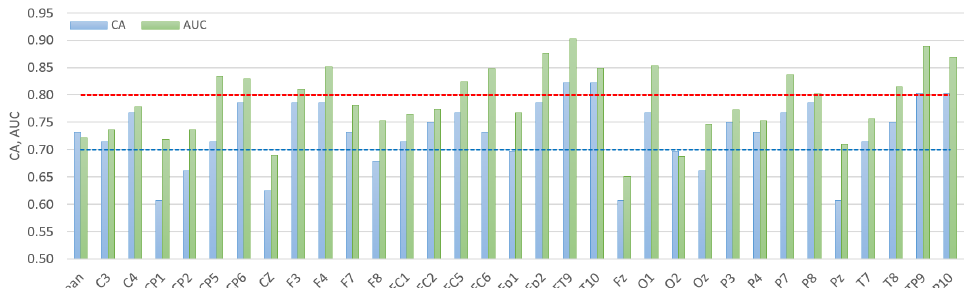
Figure 14. Classification results, mean value based on analysis of all electrodes—CA.